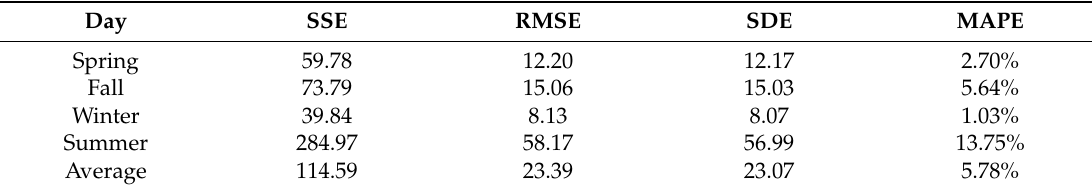
Table 6. Accuracy Analysis Summary—Stage 2.